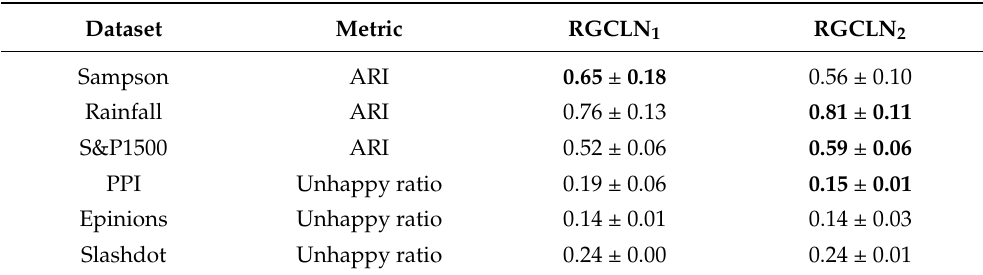
Table 3. Two variants for validating the validity of ontology features. The first three rows are evaluated with the ARI metric, while the remaining dataset without the ground truth is evaluated with the unhappy ratio.